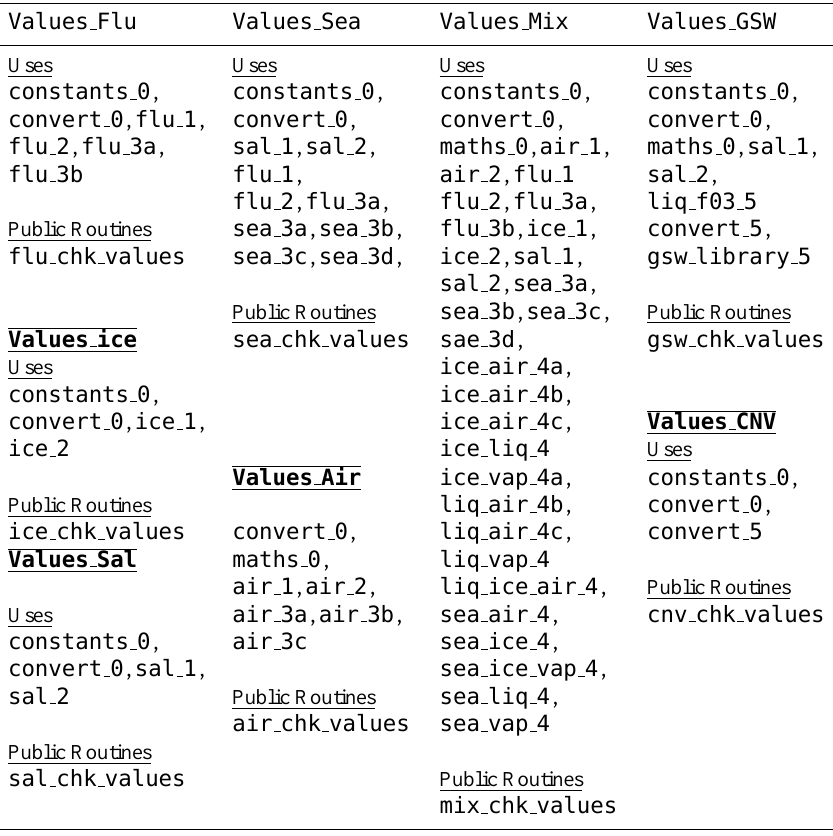
Table A2. Routines provided to easily compare results from a local implementation with those produced on the development machines. Values Flu